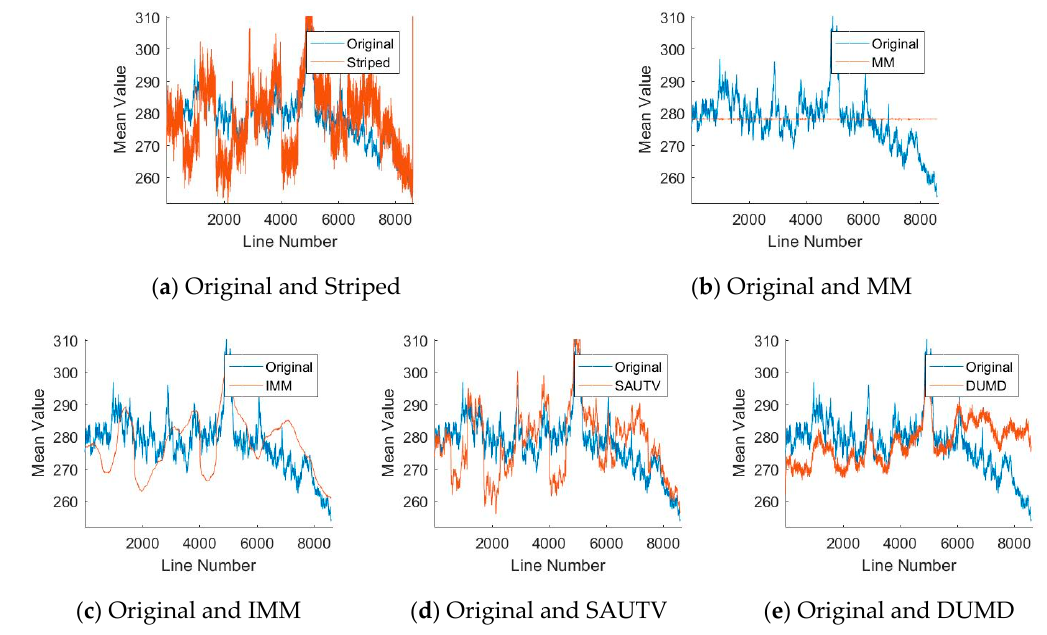
Figure 8. CMVs of Data 6 (ZY3-02). Where ( a ) is the CMVs of original image and striped image, ( b ) is the CMVs of original image and MM-processed image, ( c ) is the CMVs of original image and IMM-processed image, ( d ) is the CMVs of original image and SAUTV-processed image, ( e ) is the CMVs of original image and DUMD-processed image.